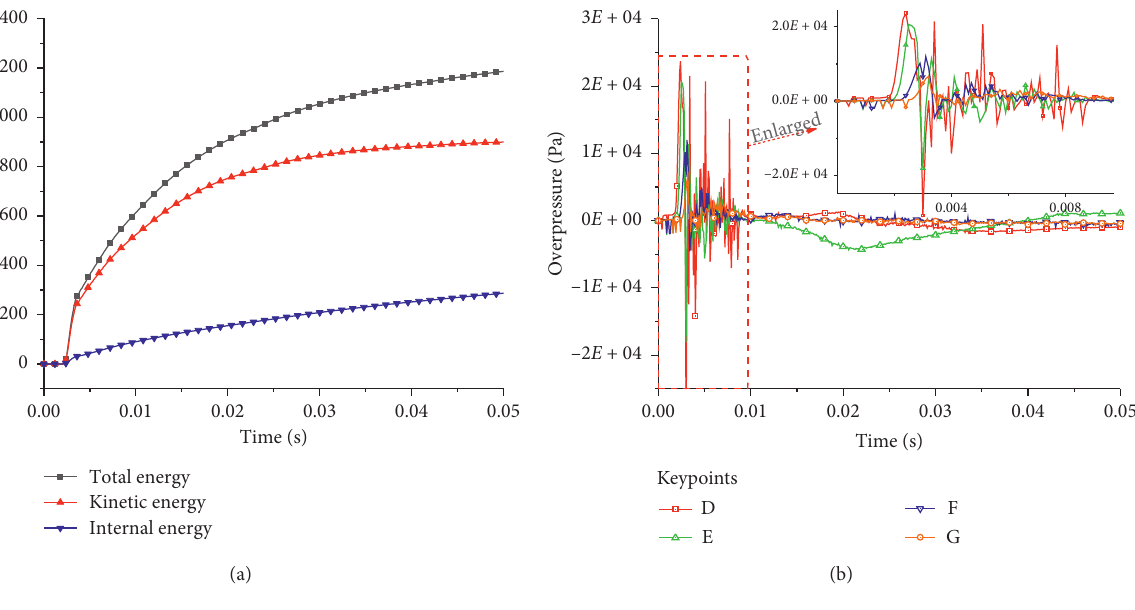
Figure 10: Dynamic response curves of different pavements.